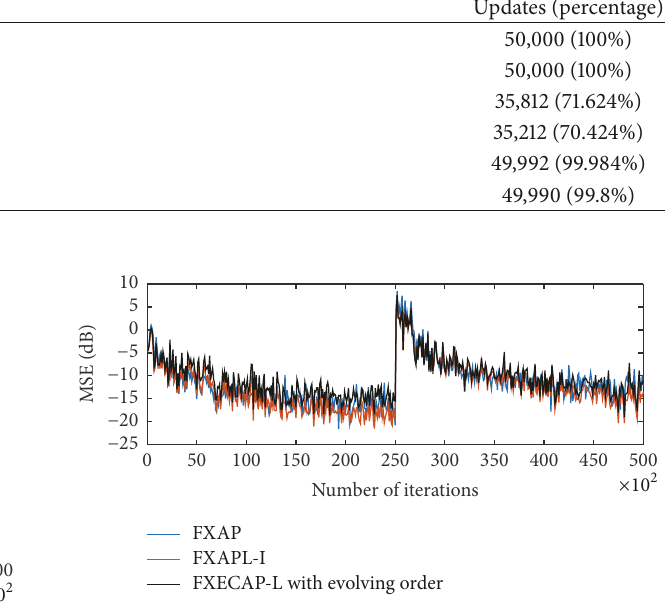
Figure 18: MSE values of the tested AP algorithms in a variant multichannel system. The projection order used is 𝐿 = 5 and 𝑏 = 2 bits are used to encode the